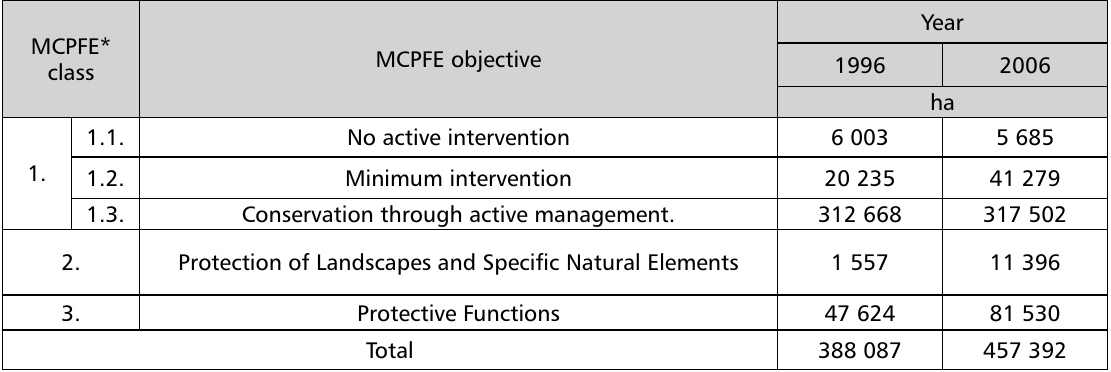
Extent of protected forests according to MCPFE classification system